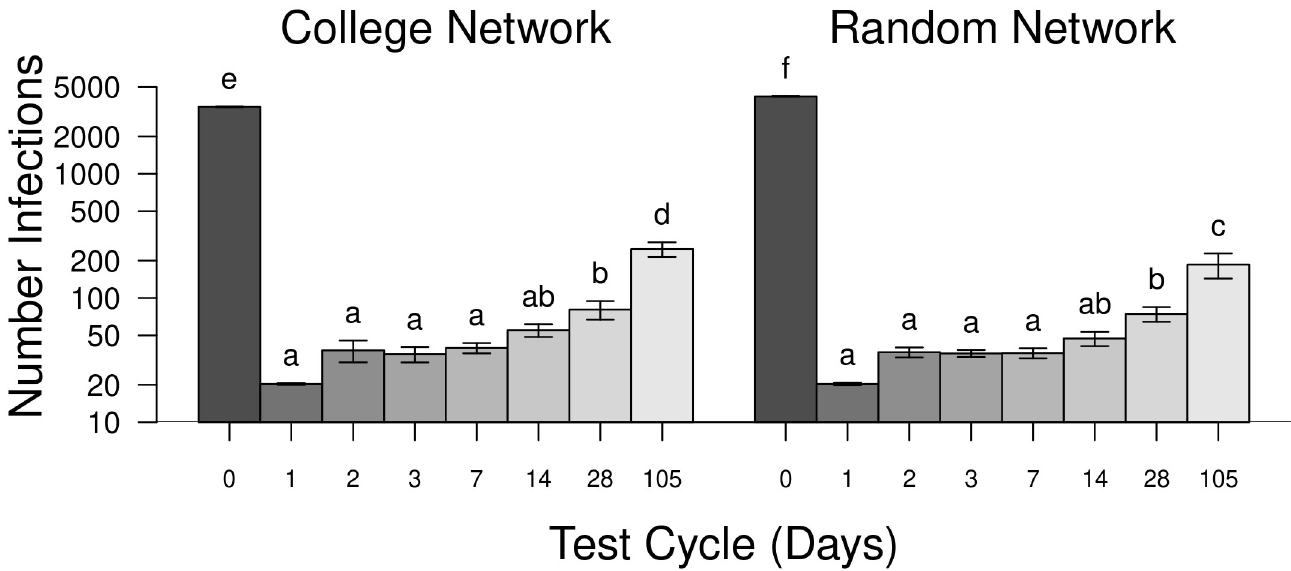
Fig 8. The number of infections for different testing frequencies for both networks. The average number of infections for simulations with testing and contact tracing at different intervals. Note that test cycles are the days between testing for individuals. The largest number of infections occurred when no testing was done (0 days), followed by testing students only once per semester (105 days). Error bars are ± 95% confidence intervals. Samples sharing letters are not statistically different.